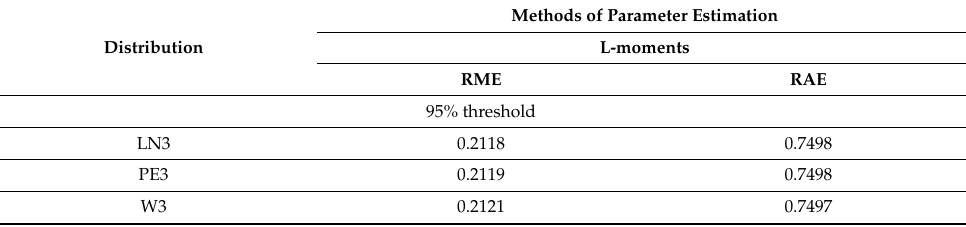
Table 13. Distribution performance values for annual deficit volumes.